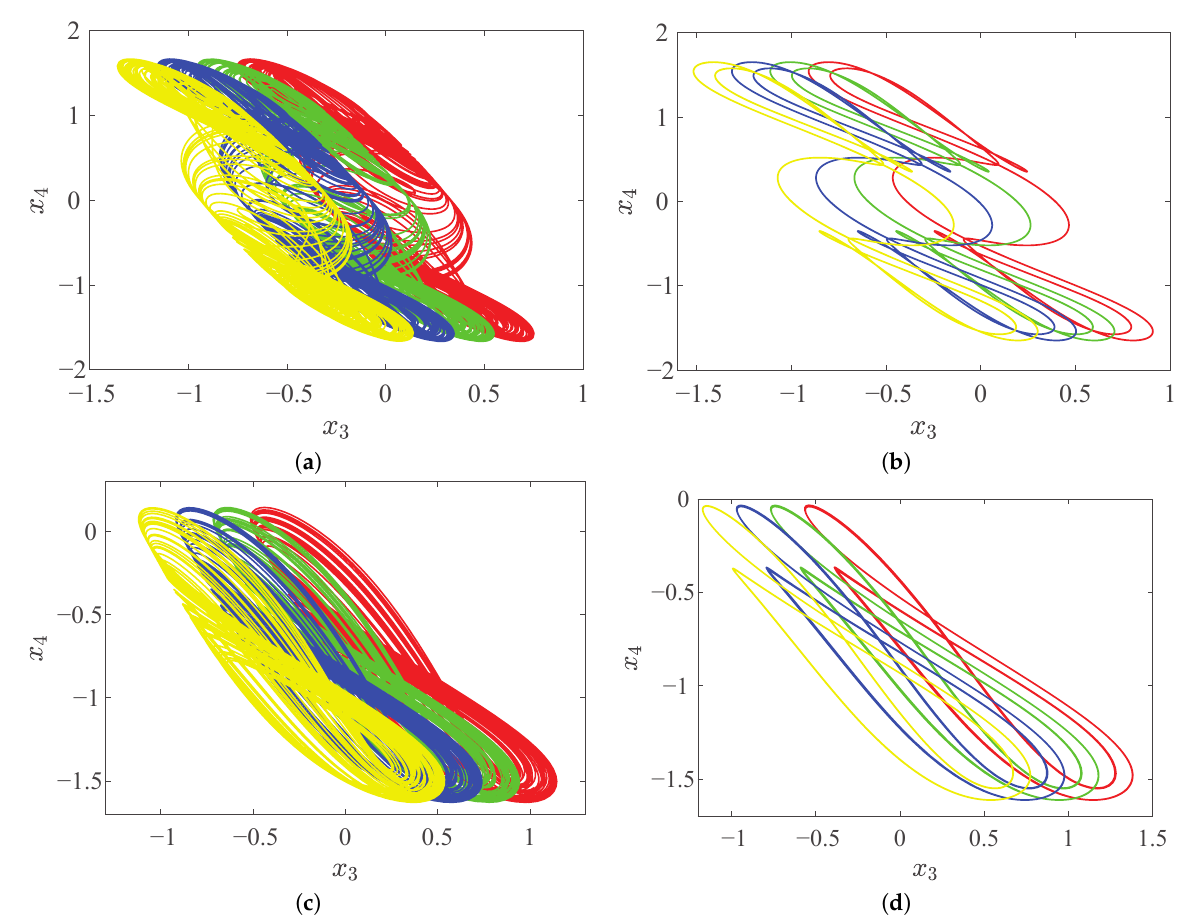
Figure 14. Offset boosting ( ¯ p = 0 (red), ¯ p = 0.2 (green), ¯ p = 0.4 (blue), ¯ p = 0.6 (yellow)) with parameter f change. ( a ) f = 9; ( b ) f = 11; ( c ) f = 14; ( d ) f = 17.